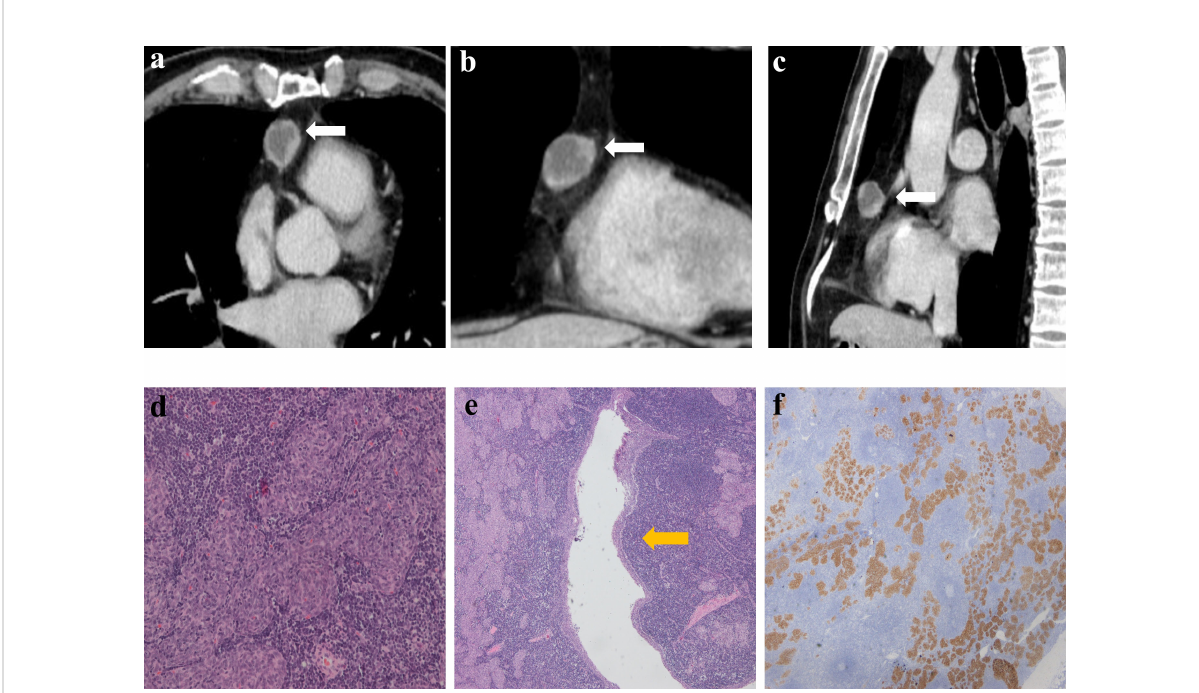
FIGURE 4 Imaging and histologic fi ndings in a 56-year-old man with primary mediastinal MTWLS (case 4). (A) Axial, (B) coronal and (C) sagittal chest CT images with contrast enhancement reveal a 2.2×2.1×2.6 cm multiple cystic region and round or oval middle anterior mediastinal mass (white arrow) adjacent to the mediastinum pleura. It had similar imaging fi ndings to the annular enhancement. (D) Hematoxylin-eosin (H-E) – stained section of the mass reveals spindle cells forming multiple micronodules separated by abundant interstitial lymphocytes. (E) Cyst walls (yellow arrow) were covered with nodular tumor. (F) The epithelial component was positive for